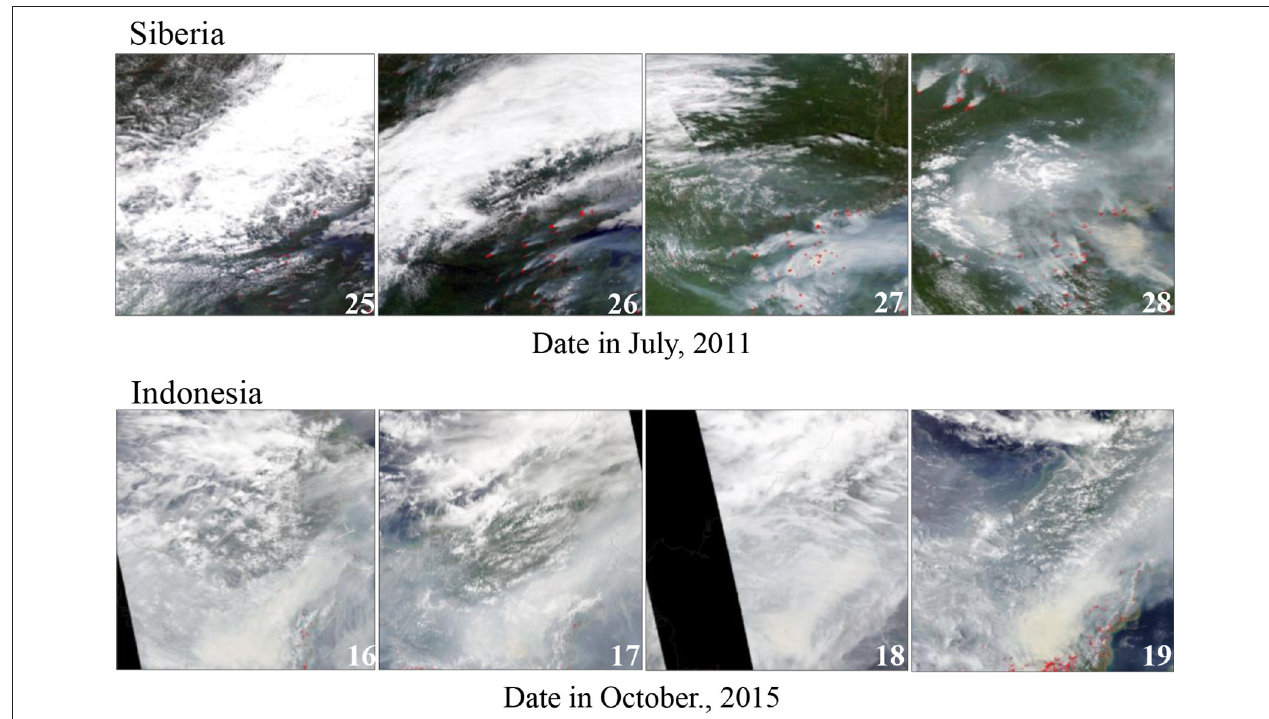
FIGURE 7 | Regional distribution of hot spots from NASA/Aqua/MODIS (MYD14 Collection 6) superposed on true color composite images consisting of MODIS bands 1, 4, and 3 (MYD02 Collection 6) for RGB color space over Siberia (Area B in Figure 4 ) from July 25–28 in 2011, and Indonesia (Area D in Figure 4 ) from October 16–19 in 2015.